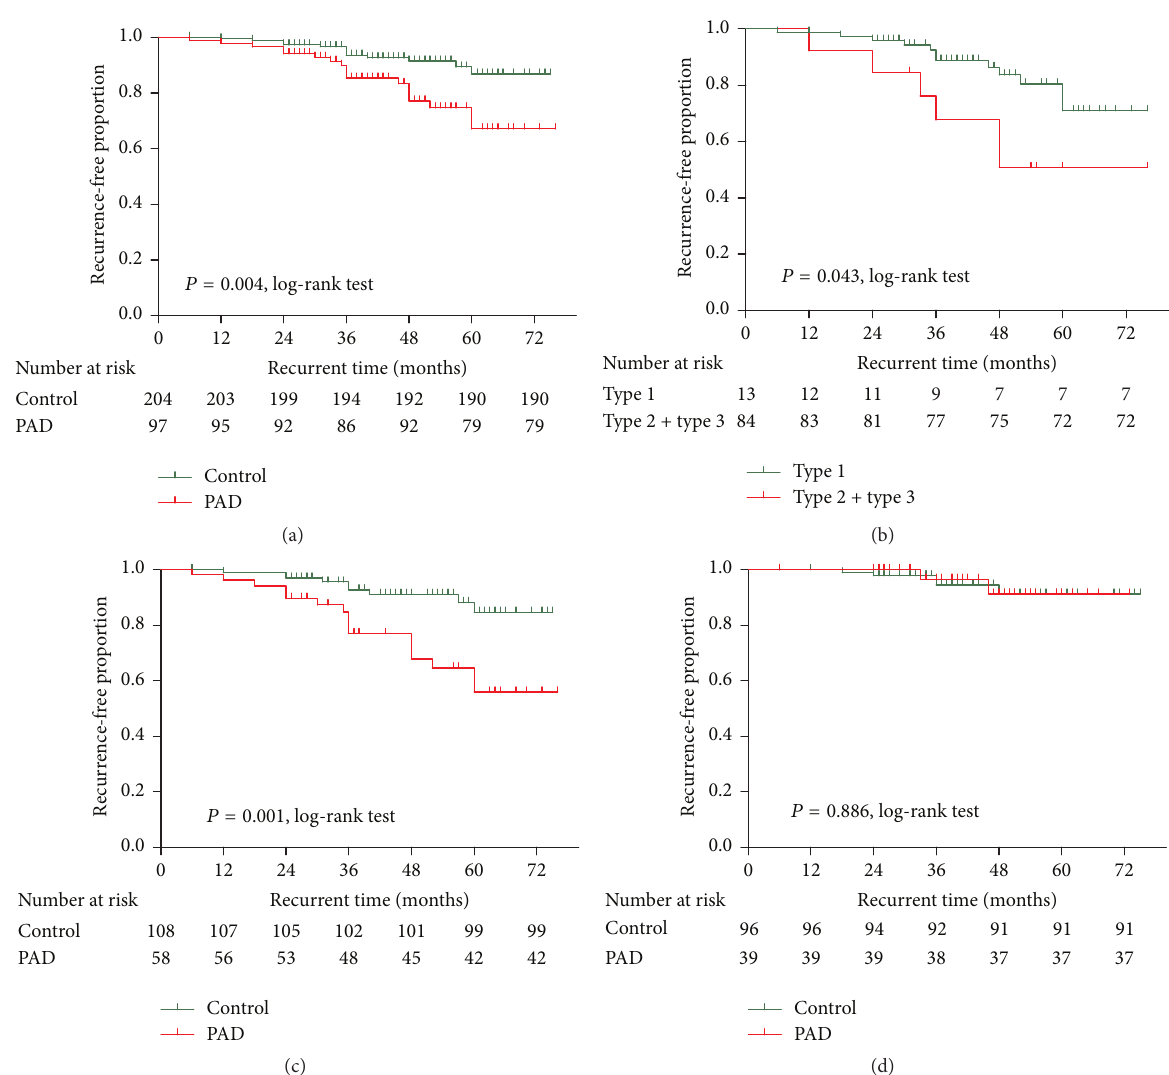
Figure 1: The actuarial probability of patients remaining free of recurrence of symptomatic CBD stones during the follow-up after therapeutic ERCP. (a) The patients with PAD versus those without PAD; (b) the patients with type 1 PAD versus those with type 2 or type 3 PAD; (c) recurrence-free probability between the two groups who underwent previous cholecystectomy; (d) recurrence-free probability between the two groups with gall bladder in